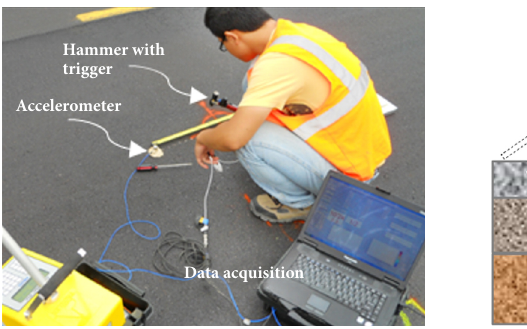
Figure 1. Surface wave method